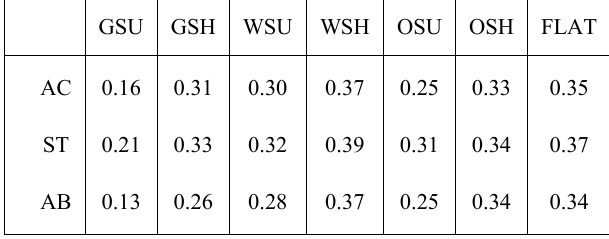
Table 3. Dynamic threshold of snow cover period.